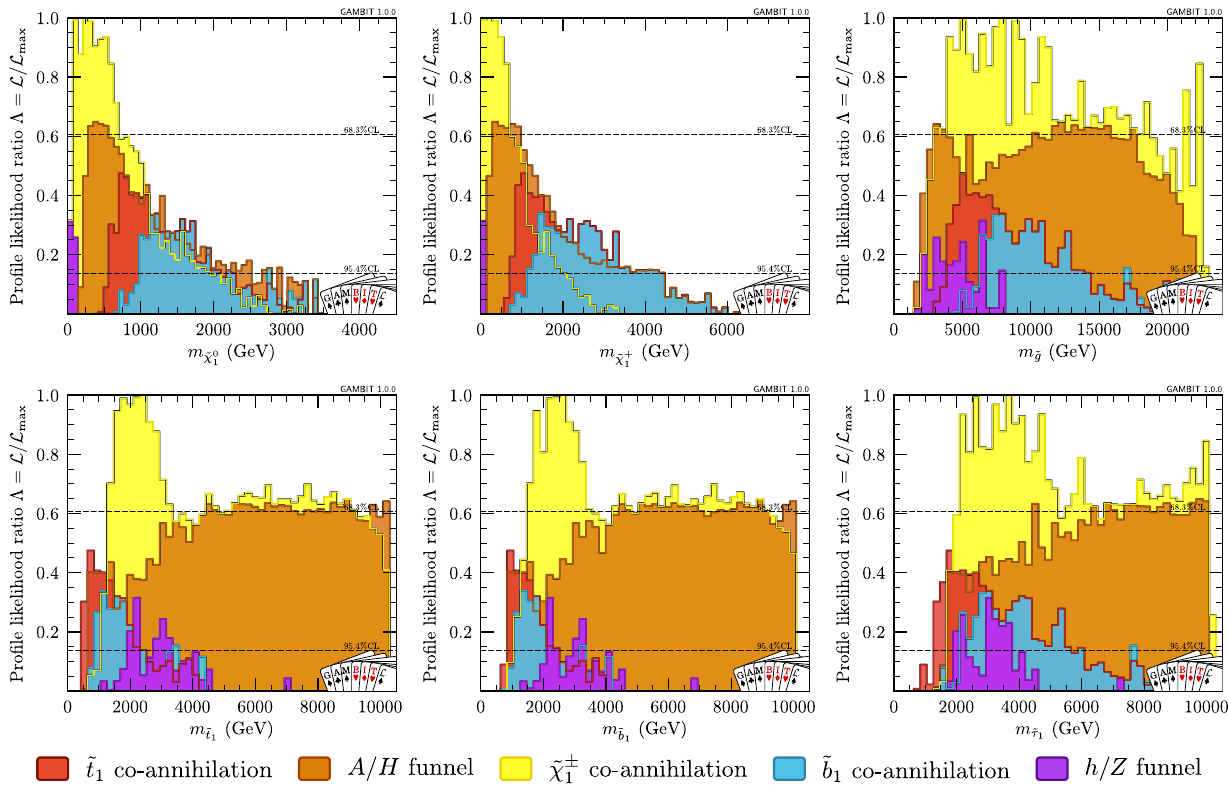
, m ˜ χ + , m ˜ g , m ˜ t , m ˜ and m ˜ τ . We show separate distributions for each mechanism that allows b 1 1 1 1 1